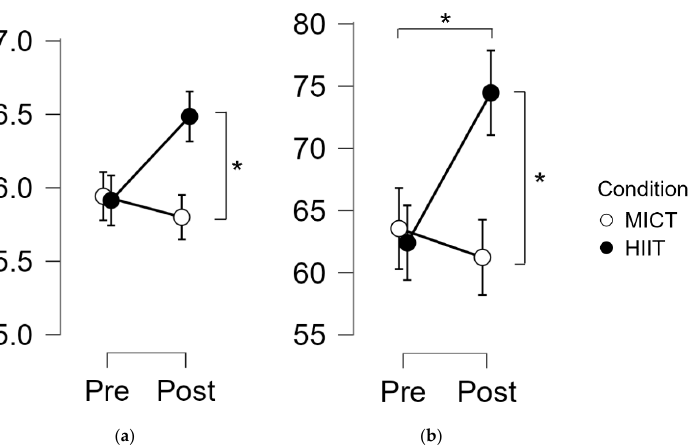
Figure 4. Visuospatial memory results. ( a ) Corsi Span Backward; ( b ) Total Score Backward. * : Indicates a significant effect of time or between conditions ( p < 0.05).